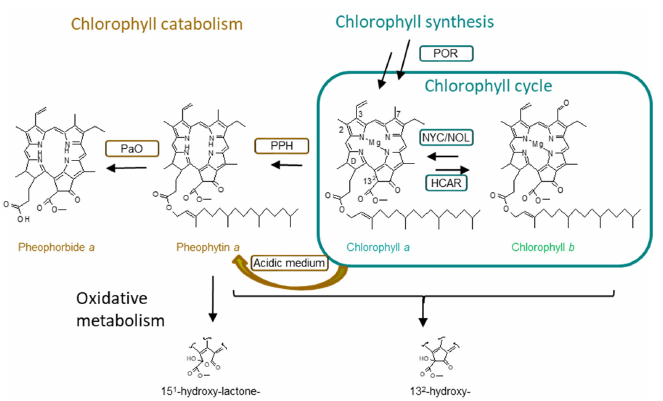
Figure 1. Chlorophyll synthesis (including chlorophyll cycle), catabolism, and oxidative metabolism, adapted from [17]. Formation of pheophytin from chlorophyll in acidic medium. POR stands for protochlorophyllide a oxido-reductase, NYC/NOL stands for nonyellow coloring and NYC1-like, PPH stands for pheophytinase, and PaO stands for pheophorbide a oxygenase.